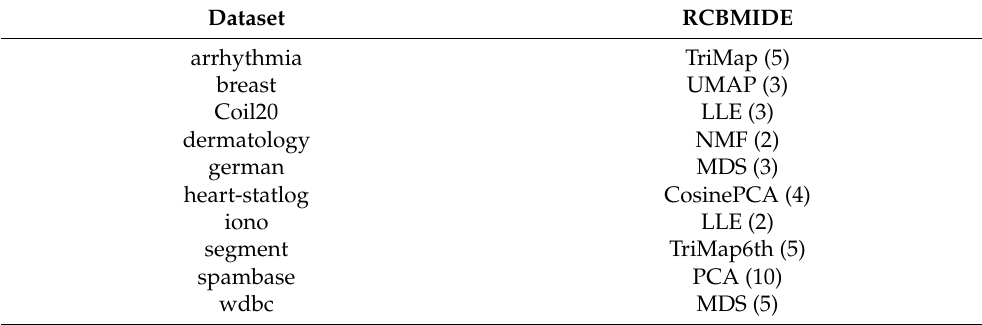
Table A1. RCBMIDE method extension (dimensionality reduction) for each higher-dimensions